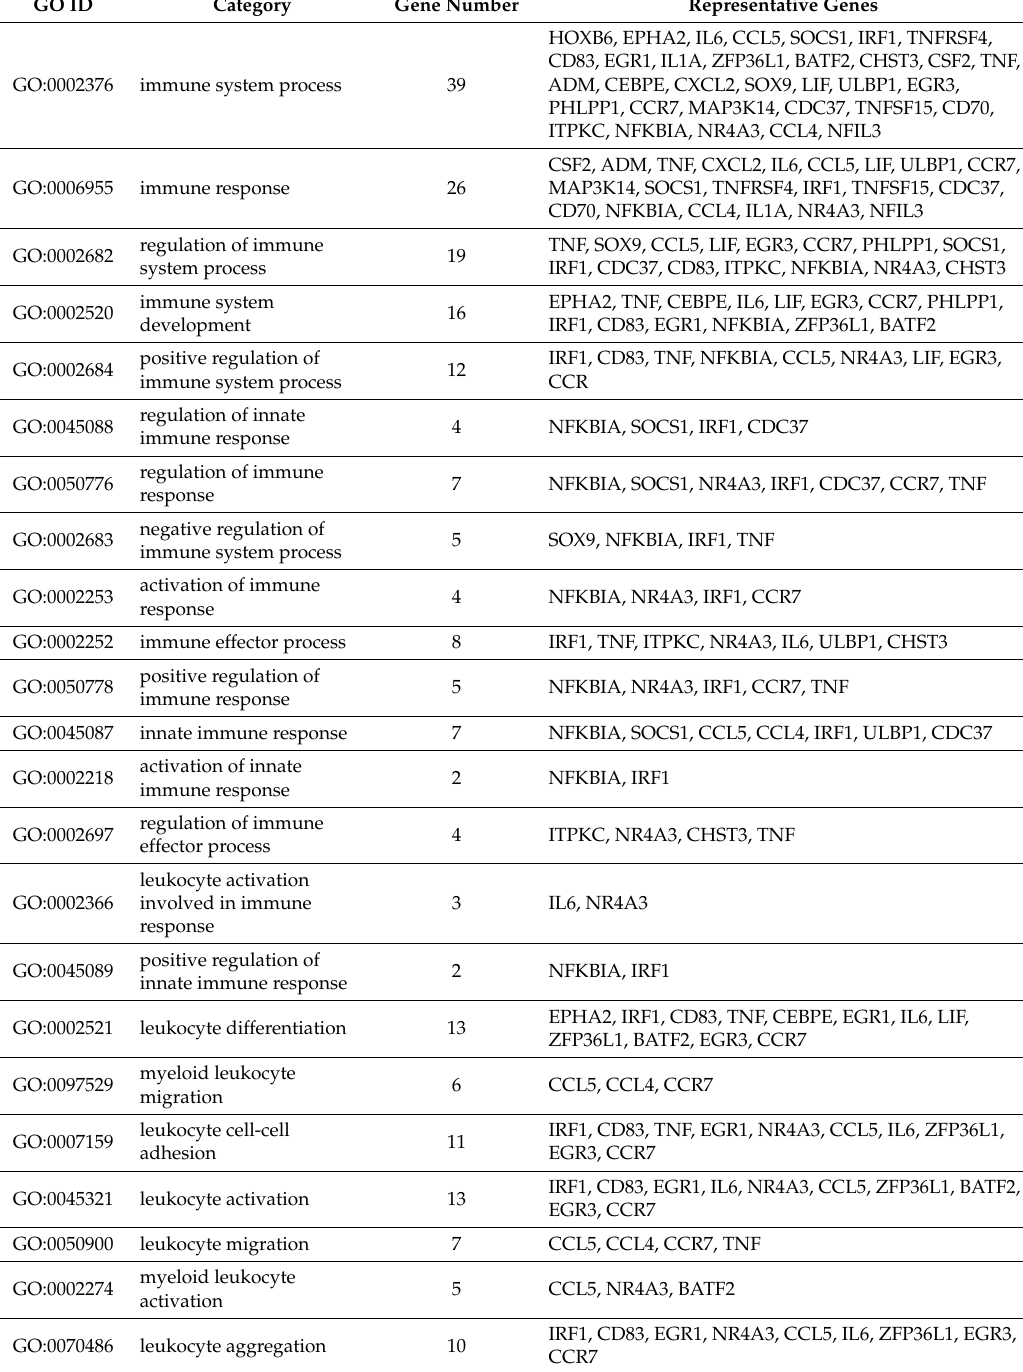
Table 4. Gene ontology (GO) analysis of immune-related